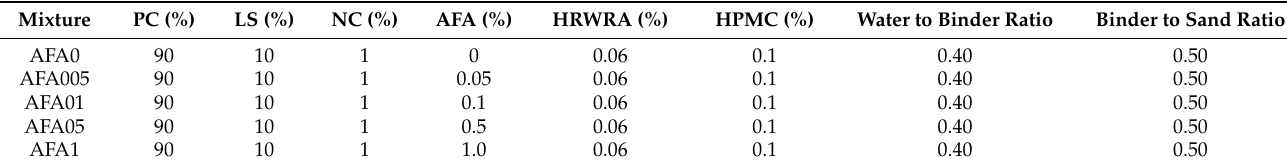
Table 2. Mix proportions of 3D printing cement